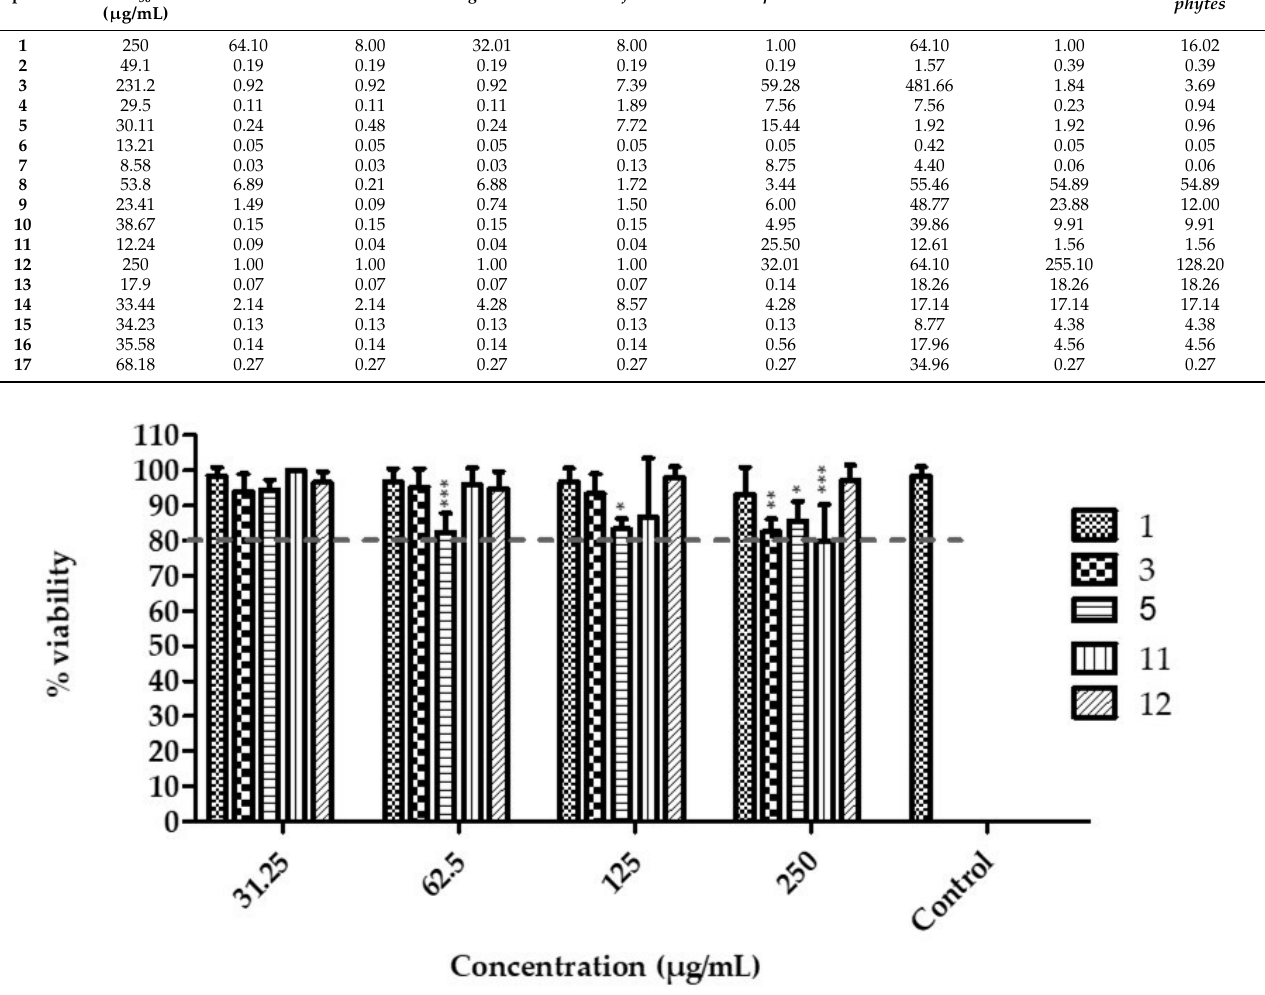
Figure 3. Caenorhabtis elegans larvae viability after treatment with the tested compounds. The larvae viability was greater than 80% with all the tested nitrofurans, even at the highest concentration of the compounds (250 µ g/mL). The effects of the compounds were compared to the control group. Nitrofurans 1 and 12 showed no statistical difference with the control group in any concentration. On the other hand, compounds 3 , 5 and 11 , at the concentration of 250 µ g/mL, showed statistical difference with the control group, with * p < 0.01, ** p < 0.05 and *** p < 0.001, respectively. Compound 5 also showed statistical difference with the control group at the concentrations of 125 µ g/mL ( p < 0.05) and 62.5 µ g/mL ( p <